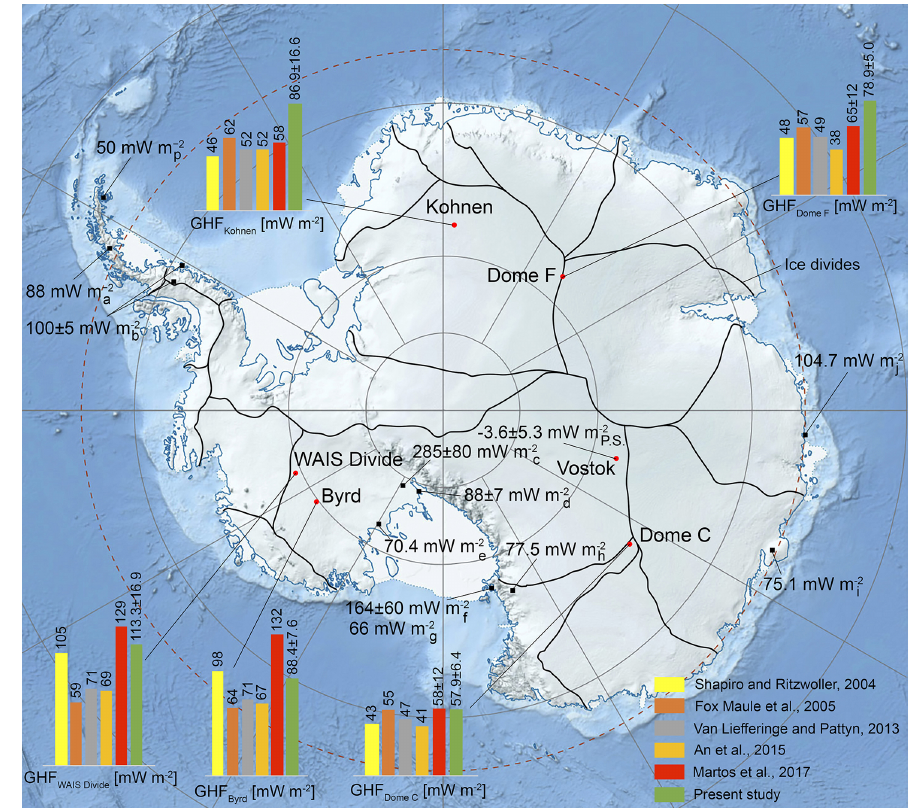
Figure 1. GHF derived in the present study (P.S.) from basal temperature gradients in deep ice boreholes (green bars) compared with modeling. Red circles show locations of deep-ice-drilling sites (Byrd, WAIS Divide, Vostok, Dome C, Kohnen, and Dome F) discussed in the present study. Black squares show locations of boreholes drilled in Antarctic margins in which borehole temperature measurements were carried out and GHF values were estimated ( a Zagorodnov et al., 2012; b Nicholls and Paren, 1993; c Fisher et al., 2015; d Begeman et al., 2017; e Engelhardt, 2004; f Risk and Hochstein, 1974; g Decker and Bucher, 1982; h Clow et al., 2011; i Dahl-Jensen et al., 1999; j Zotikov, 1961). Drill sites in ocean and subshelf sediments are not shown. Location of the Antarctic ice divides is shown according to Rignot et al. (2011).